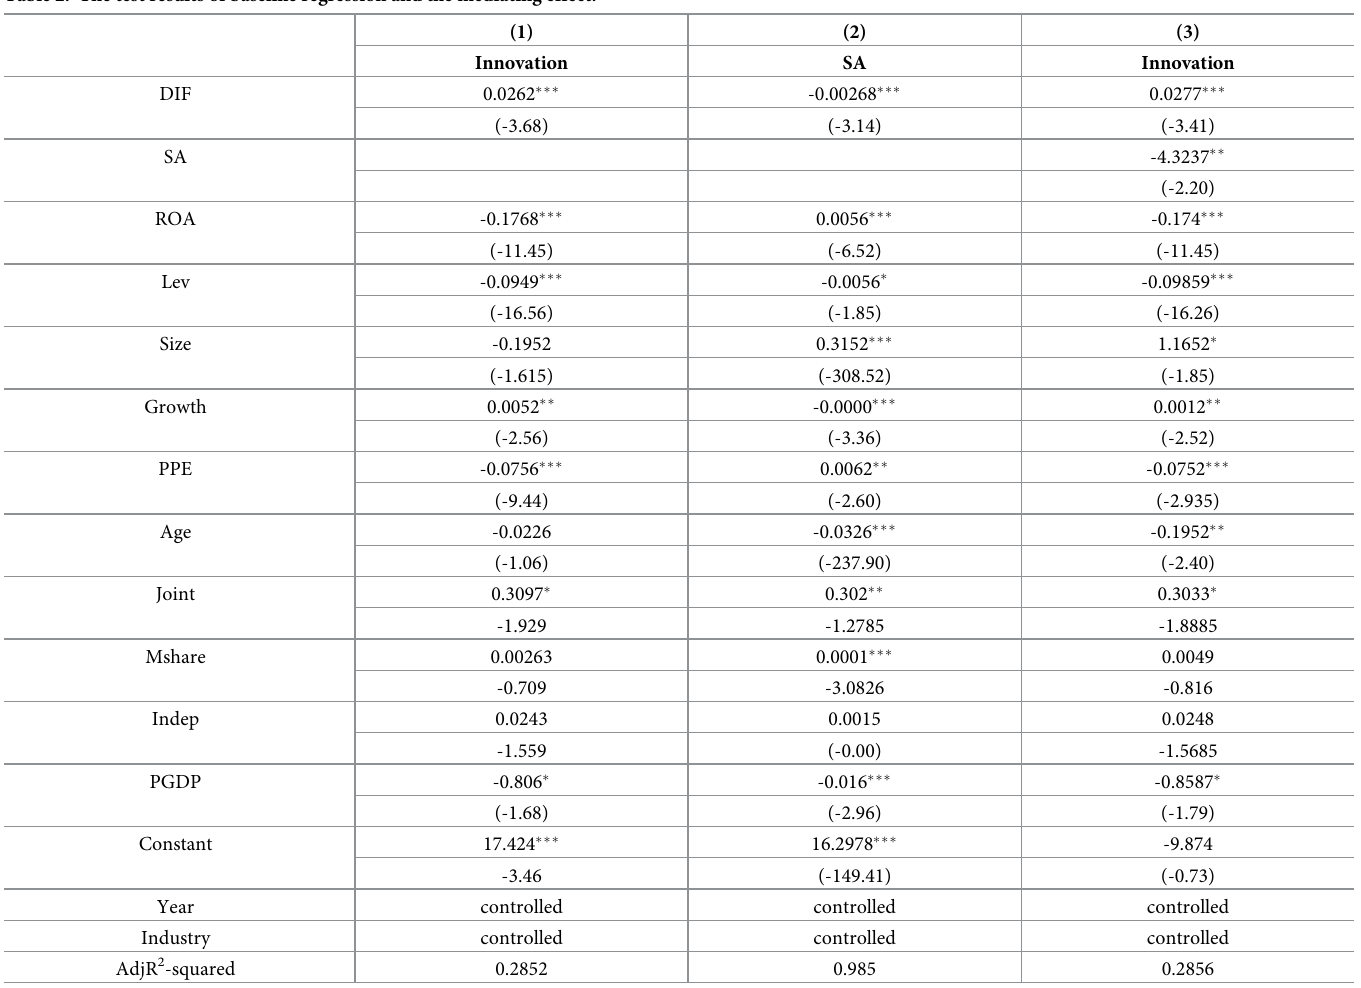
Table 2. The test results of baseline regression and the mediating